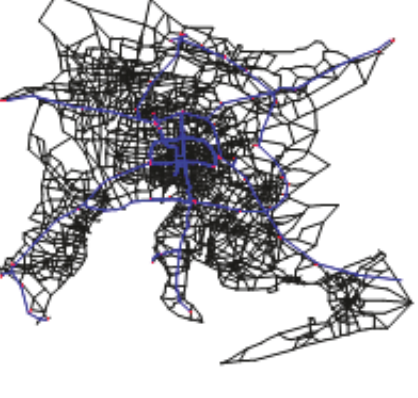
Figure 3: Study network.